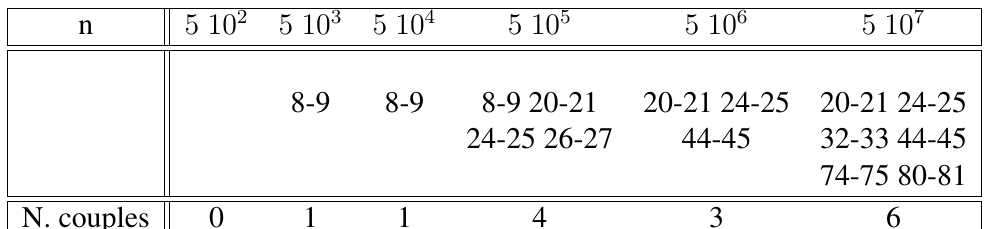
Table 4: Couples of ν for which inequality (11) is not